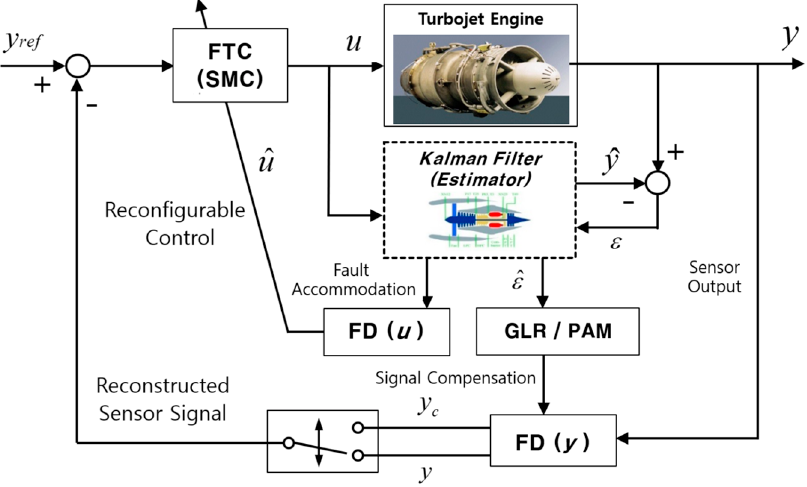
Figure 2. Schematic of fault diagnosis (FD) and fault tolerant control (FTC) with sliding mode control (SMC) in the turbojet engine control system.